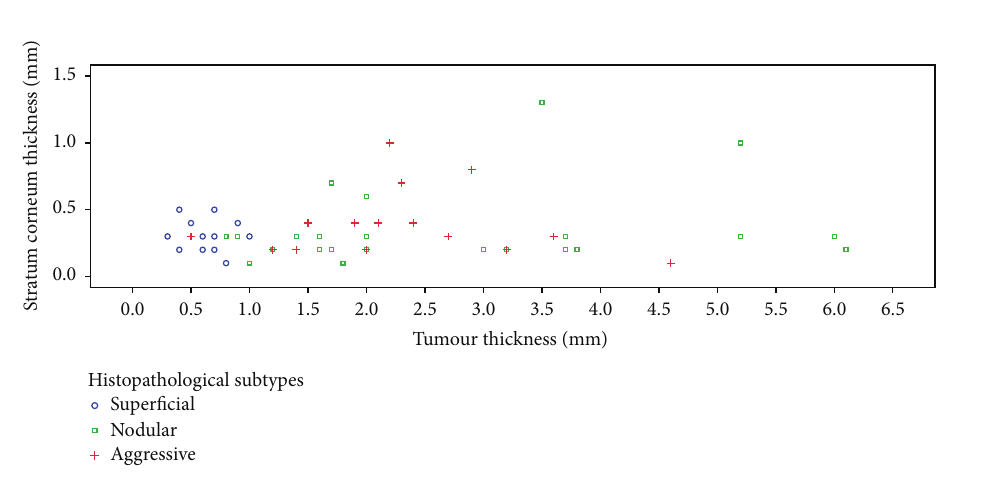
Figure 1: Plot of corresponding stratum corneum thickness versus tumour thickness of individual BCCs.